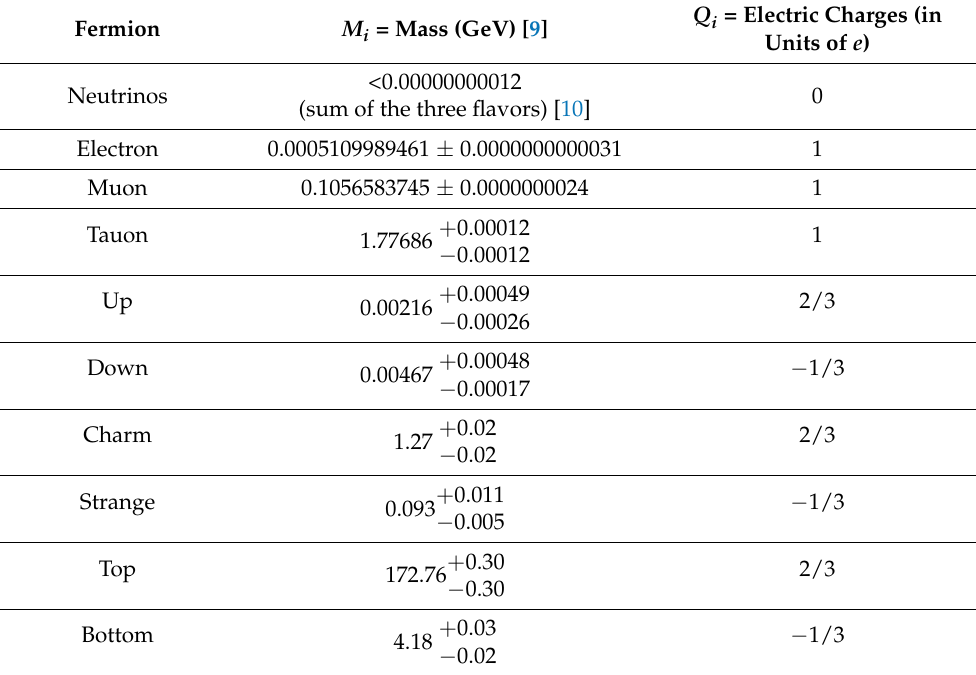
Table 2. Mass and electric charge of the elementary fermions of the SM [1,9,10].